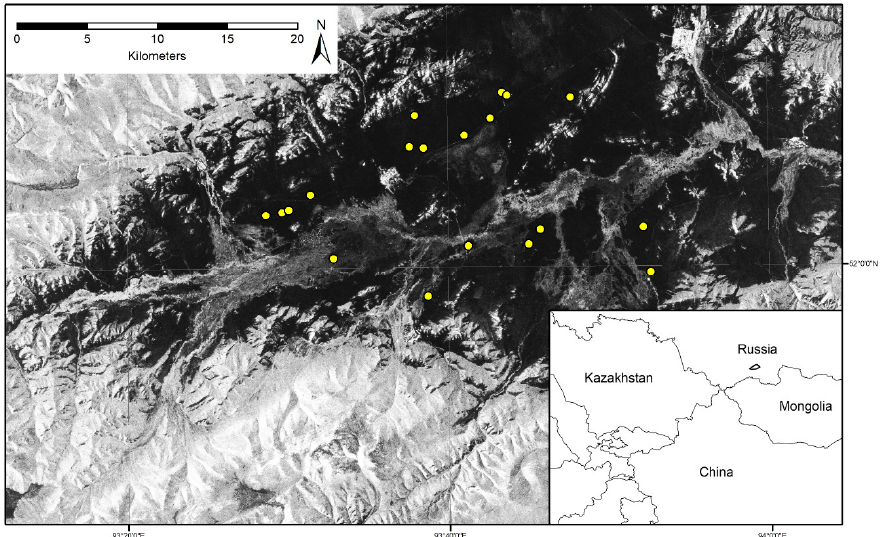
Figure 1. The survey area in Southern Siberia, Tuva Republic (Russian Federation), with circular anomalies detected in PALSAR-2 data indicated in anomalies detected in PALSAR-2 data indicated in yellow.